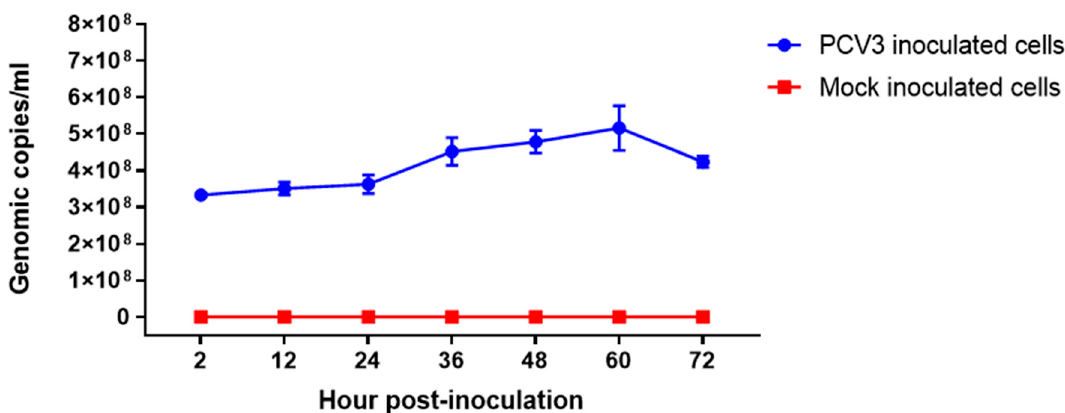
Figure 1. In vitro PCV3 growth kinetic curve. PK-15 cell cultures (six replicates per time point) were inoculated with PCV3 isolate ISU27734 passage 3 containing 3.33 × 10 8 genomic copies per mL (Cq 17.8) or mock-inoculated (infection medium), and incubated at 37 ◦ C with 5% CO 2 for 72 h. Time 2 corresponded to cell culture 2 h after virus inoculation. Virus was harvested every 12 h and the genomic copies per mL were assessed by qPCR. Each time point is represented by the mean of six technical replicates and bars represent the standard error (SE) of the mean.